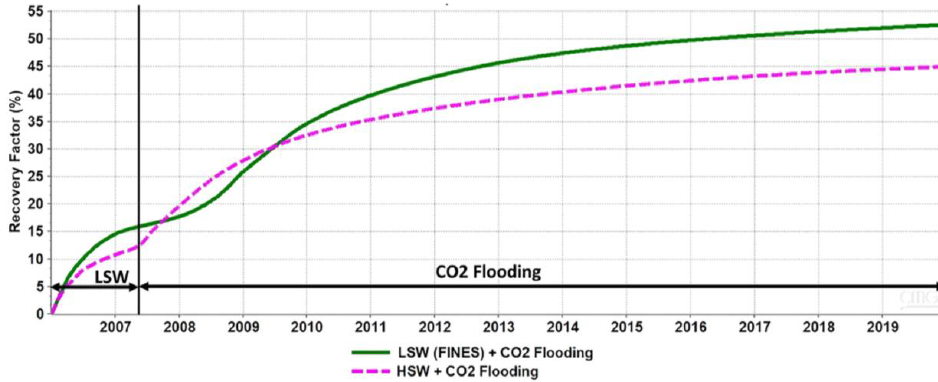
Figure 13. LSW + CO 2 flooding vs. HSW + CO 2 flooding at field scale